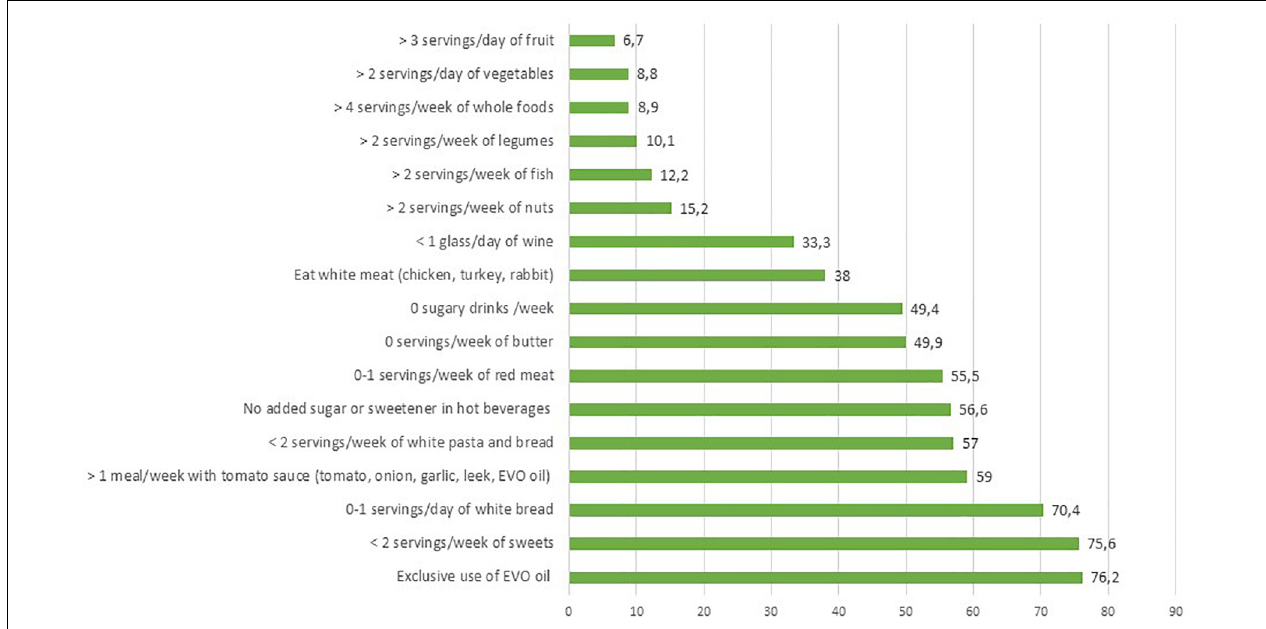
FIGURE 5 | Prevalence of answers in line with adherence to the Mediterranean